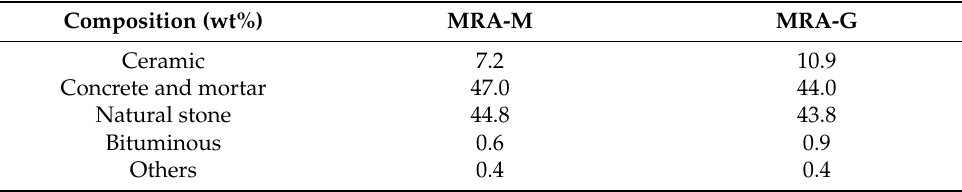
Table 2. Composition of recycled